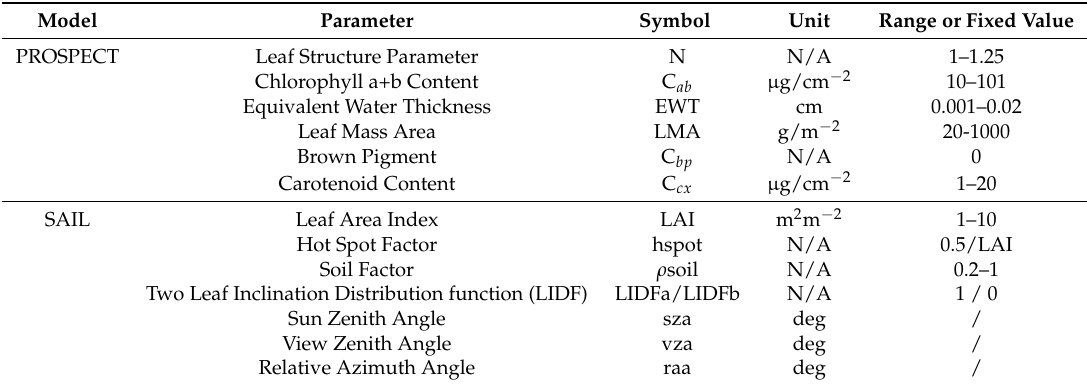
Table 1. The input parameters of the PROSAIL model with units and range (minimum and maximum) used in the inversion detailed in this